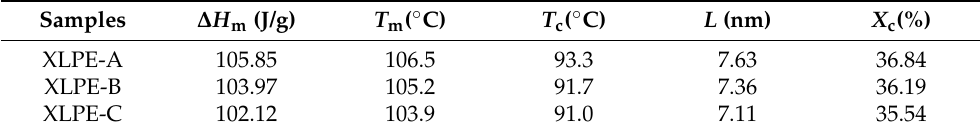
Table 2. Parameters of crystallization obtained from DSC curve.